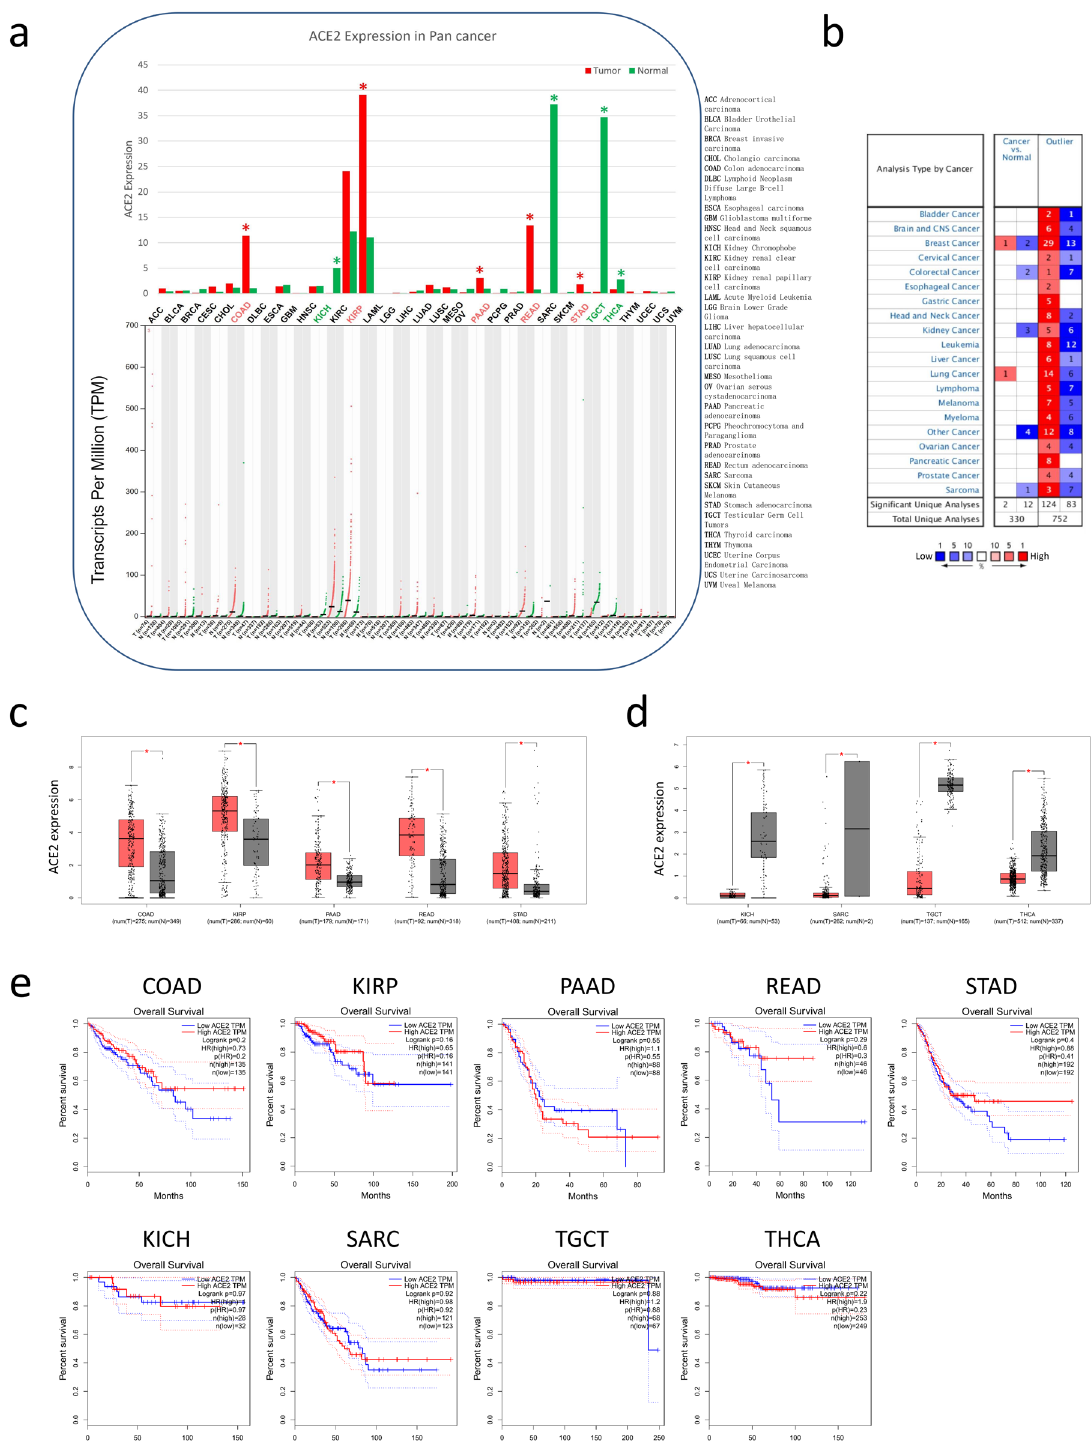
Figure 3: Expression and prognostic value of ACE2 in pan - cancer. Expressions of ACE2 were evaluated in pan - cancer compared with normal tissue from the GEPIA ( a ) and ONCOMINE ( b ) . ACE2 was overexpressed in fi ve cancer types ( c ) and decreased in four cancer types ( d ) . The prognostic value of ACE2 in nine cancer types from the GEPIA ( e ) . * P < 0.05. ACE2: angiotensin - converting enzyme 2; GEPIA: Gene Expression Pro fi ling Interactive